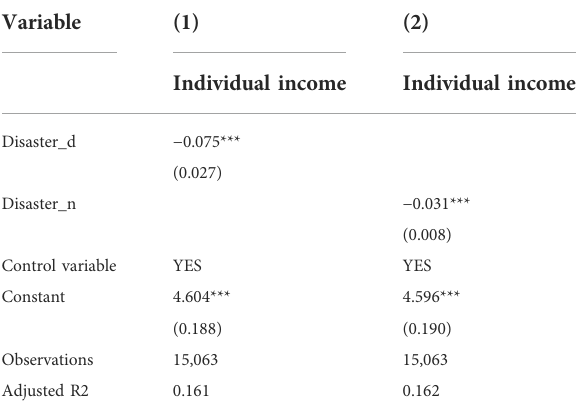
TABLE 10 Impact of natural disasters on individual income.